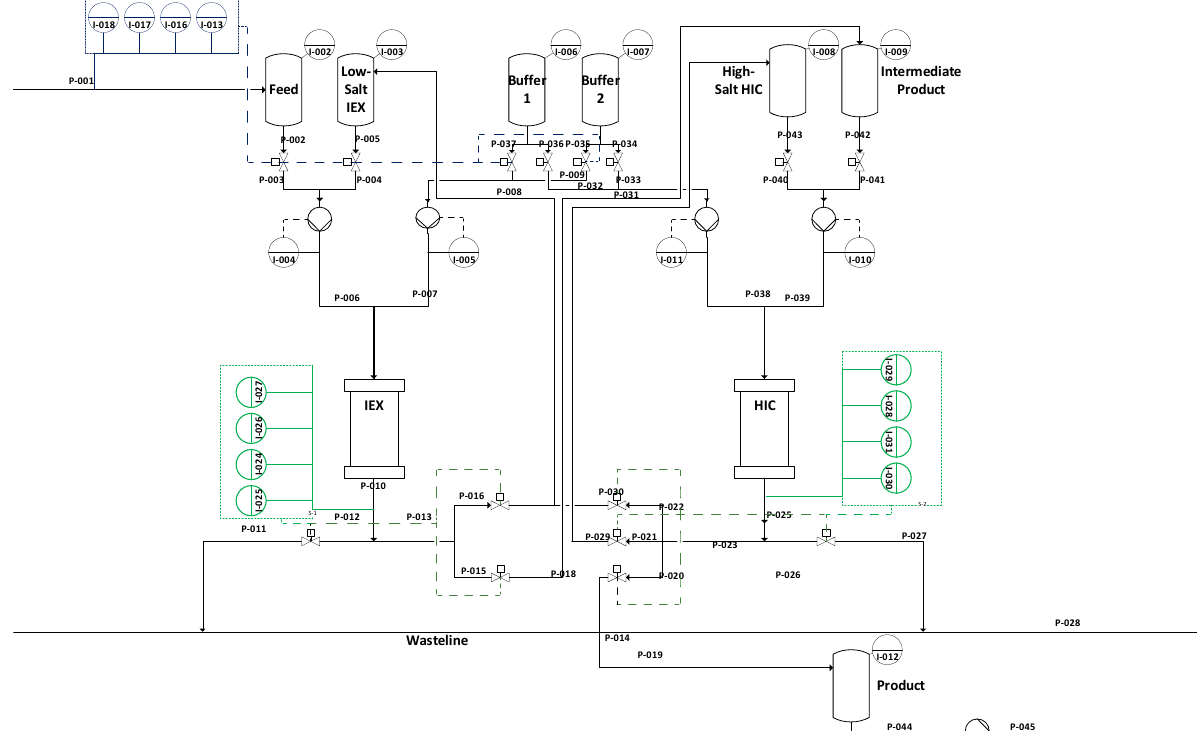
Figure 20. Proposed control strategy for iCCC. PAT measurement information from the precipitation outlet (top left, blue) is used to control the loading time of the IEX. Fractionation in the IEX can also be monitored and controlled by the described PAT detectors (green).